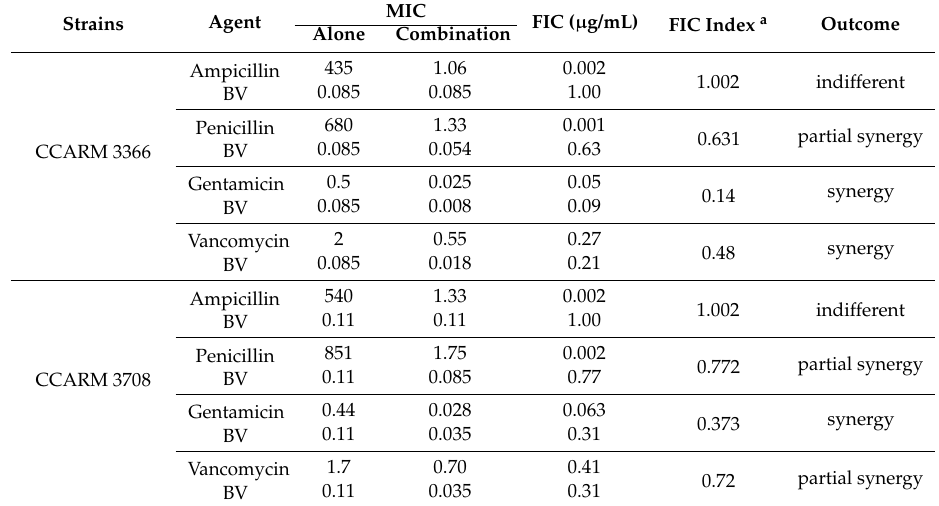
Table 2. Synergistic effects of BV with ampicillin or penicillin against Methicillin-resistant Staphylococcus aureus MRSA 3366 and 3708.